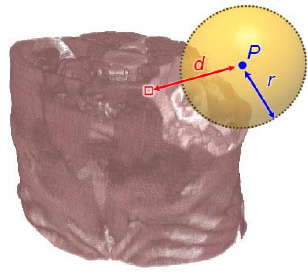
Fig. 4. 3D Digger tool: eliminating voxels from the